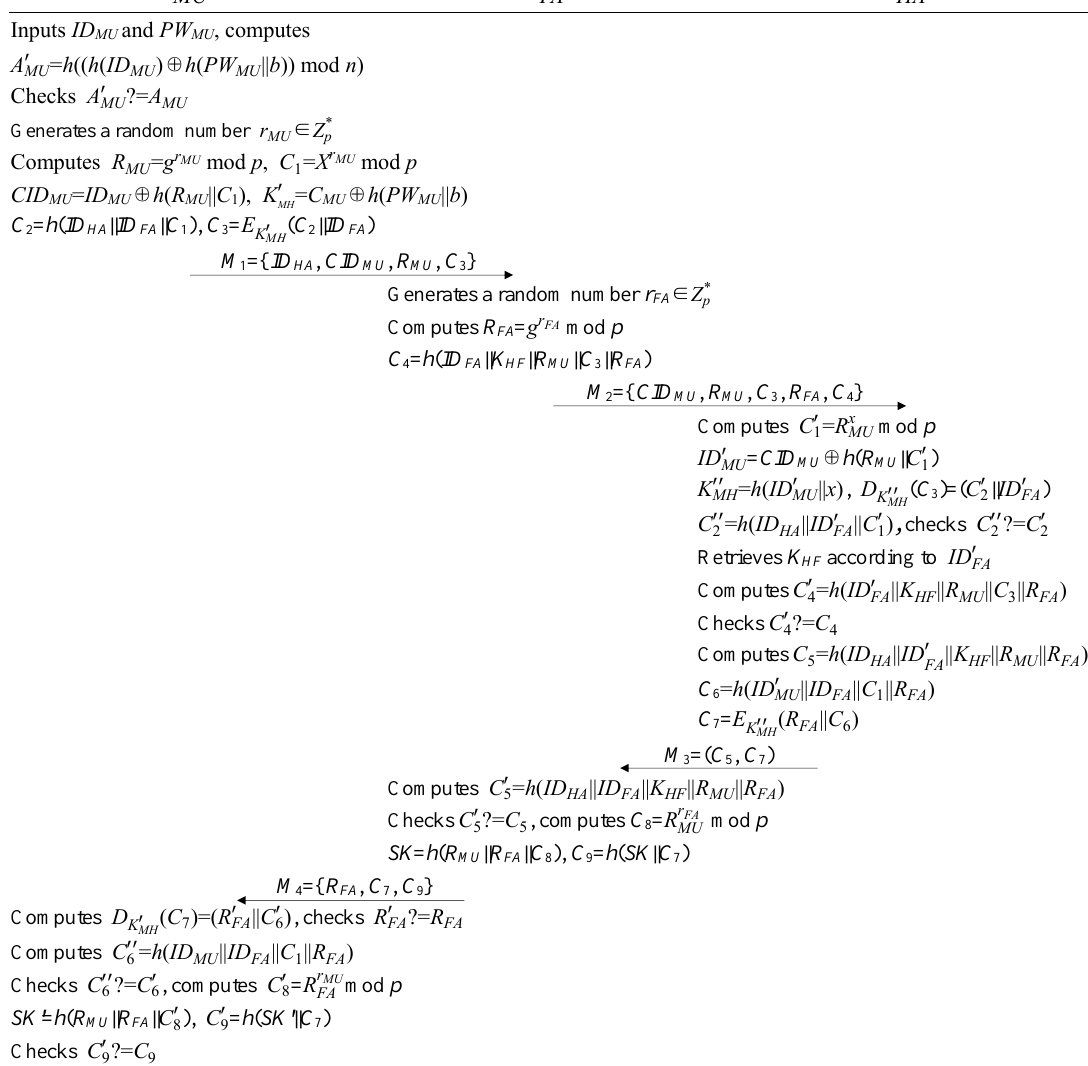
Figure 1. Login and verification